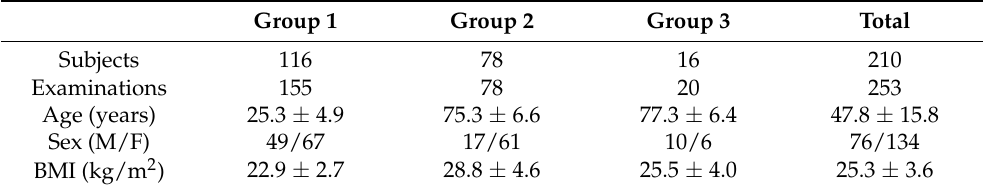
Table 1. Demographic characteristics of the database used in this study.